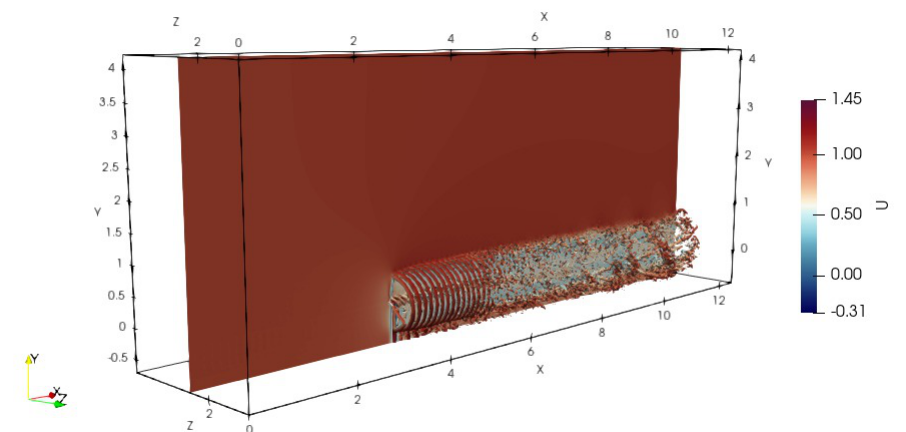
Figure 1. Streamwise velocity contours of a flow snapshot extracted from LES.